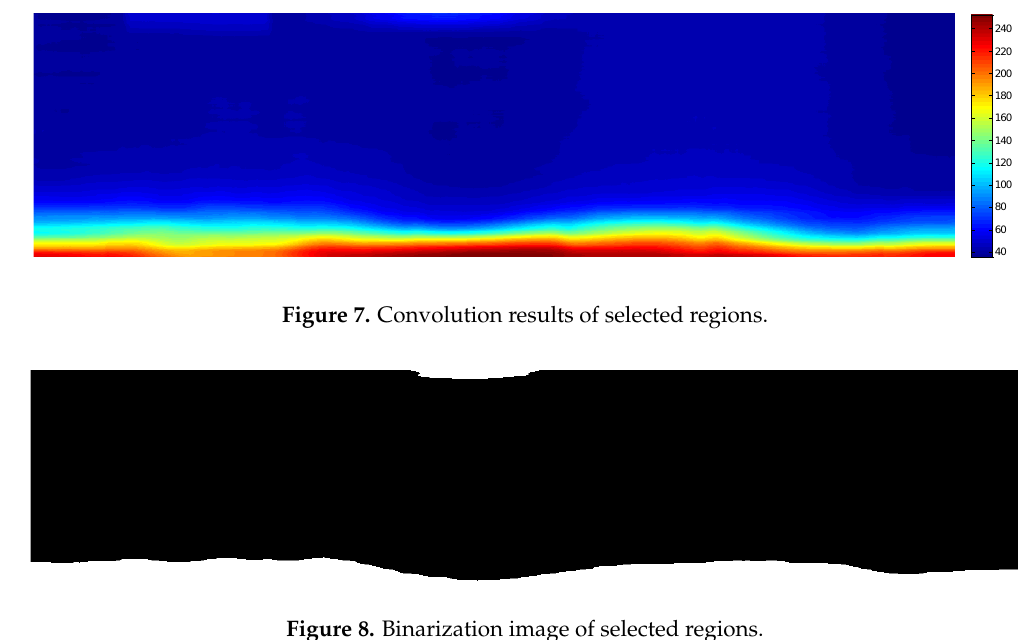
Figure 8. Binarization image of selected regions.